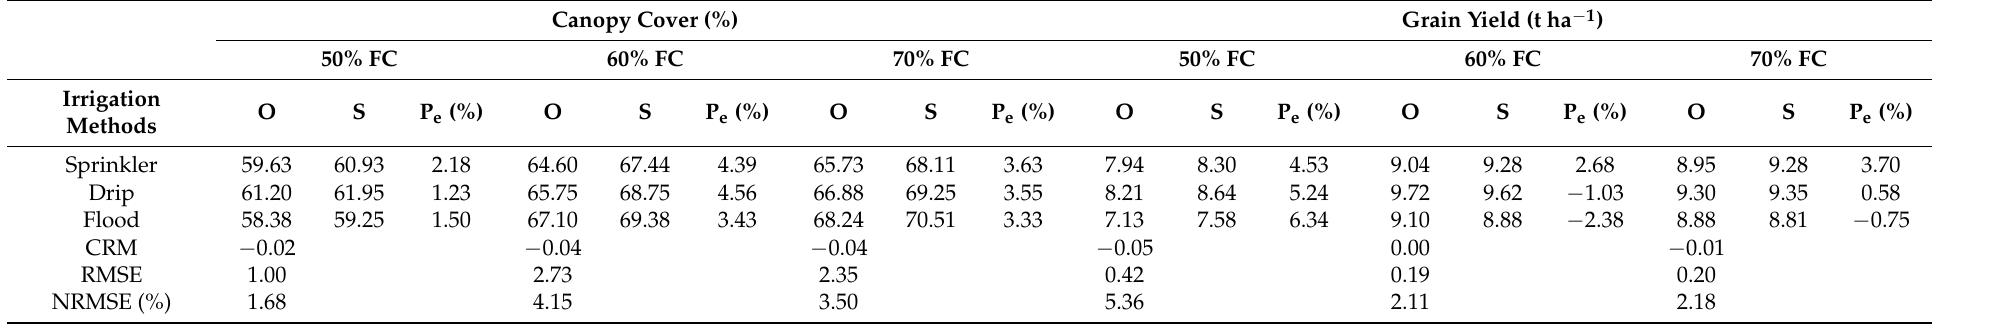
Table 9. Validation results of canopy cover and grain yield of winter wheat during the 2017 − 2018 season.